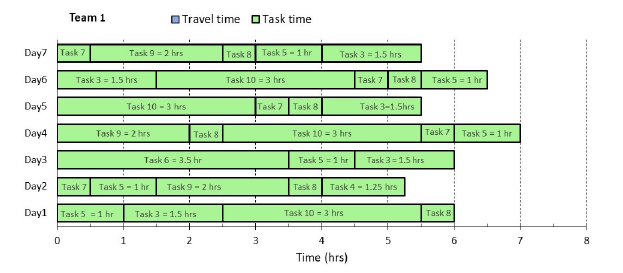
Fig. 3- a . The daily schedule of team 1 at zero distances (efficiency =74.5%)